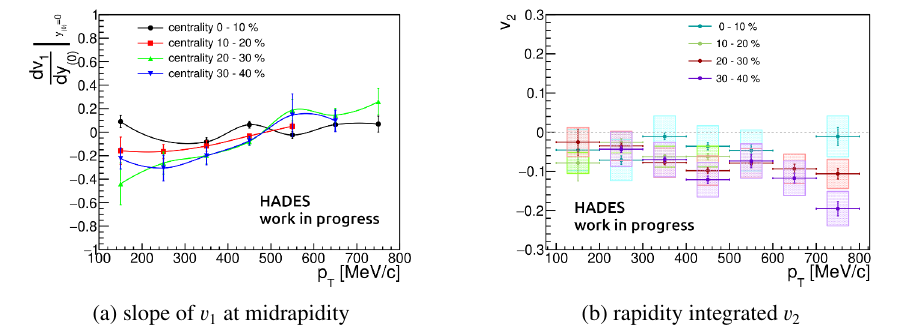
Figure 2: Centrality dependence of transverse flow of K +